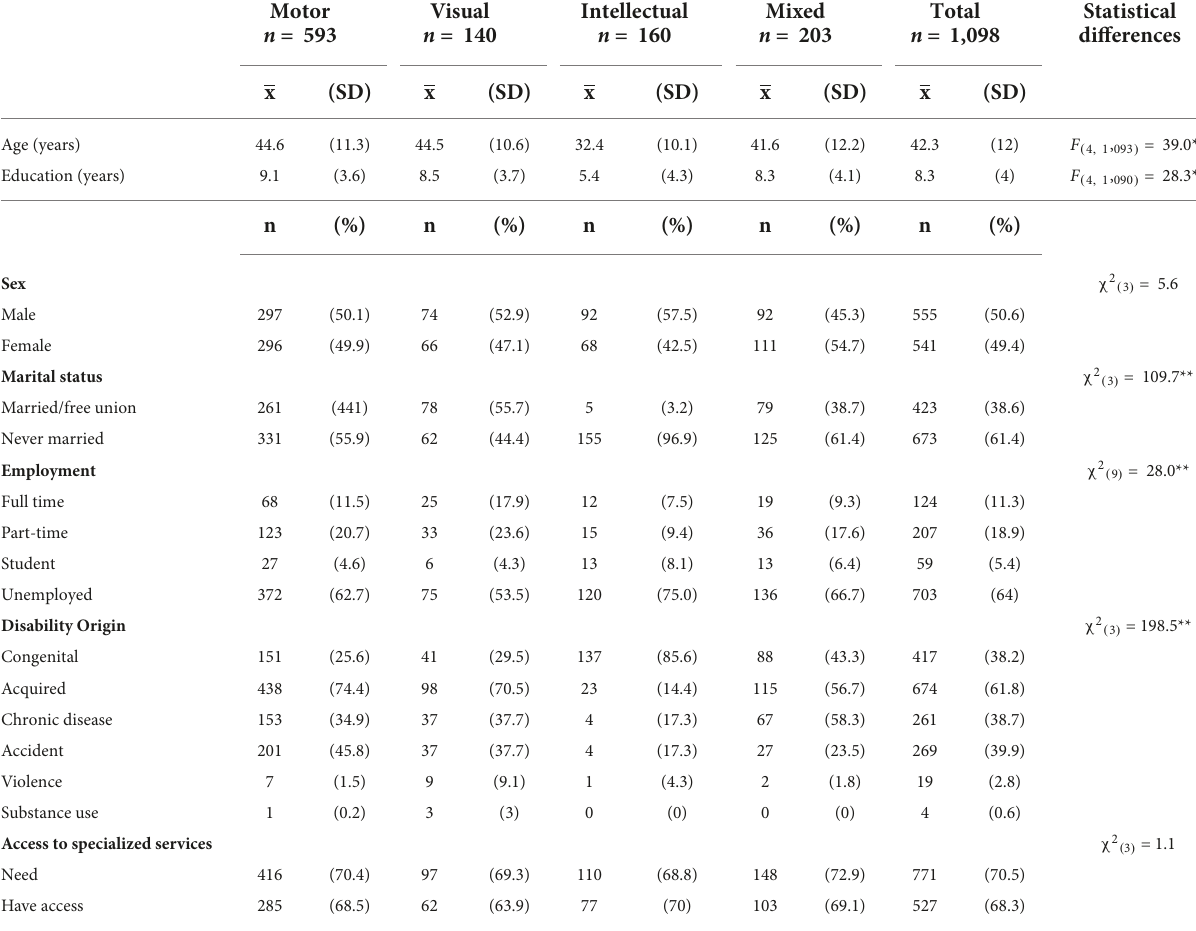
TABLE 1 Demographic characteristics of the sample by disability